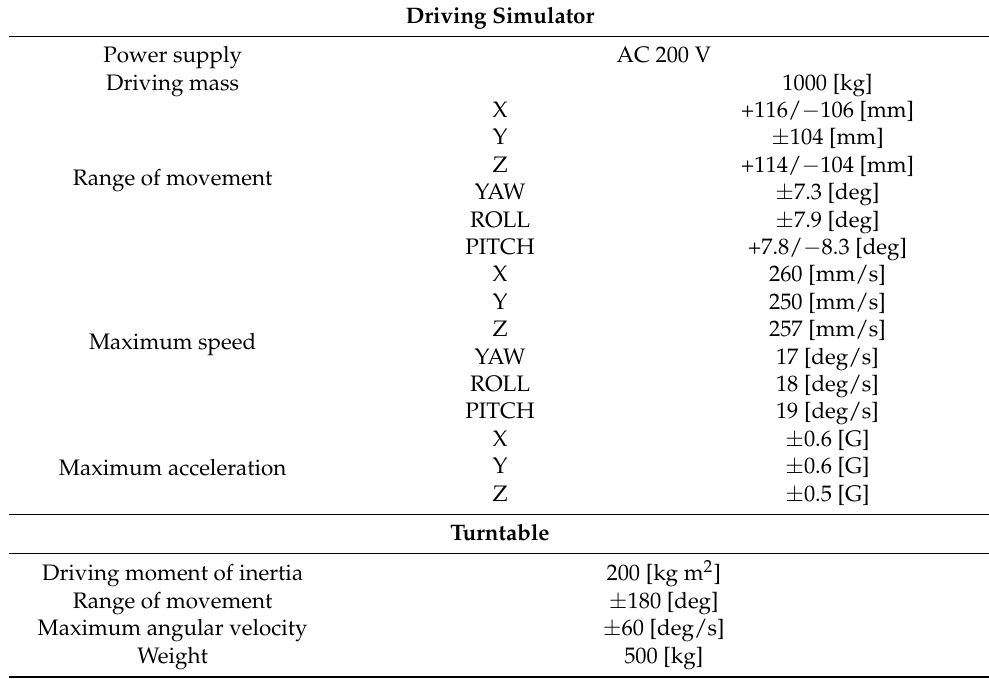
Table 1. Specification of the driving simulator and turntable.